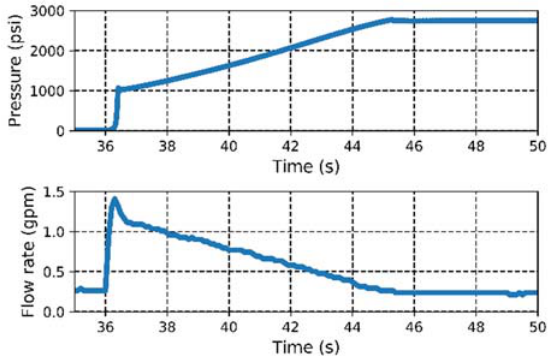
Figure 8. Pressure and flow rate while charging.